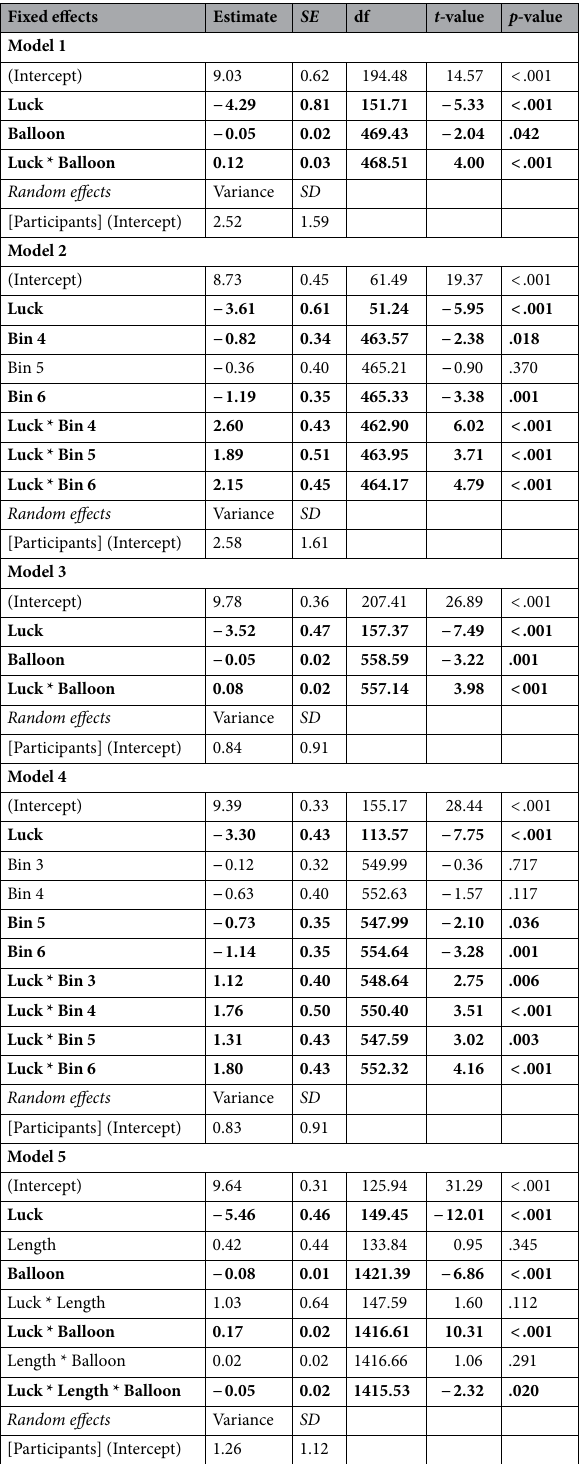
Table 3. Summary of linear mixed-effects models on the number of pumps that did not burst in Experiment 1. Dependent variable in all models: Number of pumps on each balloon that did not burst. Model 1 and Model 2 were fit to the remaining balloons of the long-manipulation conditions, Model 3 and Model 4 were fit to the remaining balloons of the short-manipulation conditions; Model 5 was fit to all balloons of all conditions. For a more detailed description of each model, see main text. With the treatment contrast, the reference level of a given factor was used to estimate the other levels. These were lucky, long, Bin 2 (Model 4), and Bin 3 (Model 2). Significant effects are in bold . SE : standard error; SD : standard